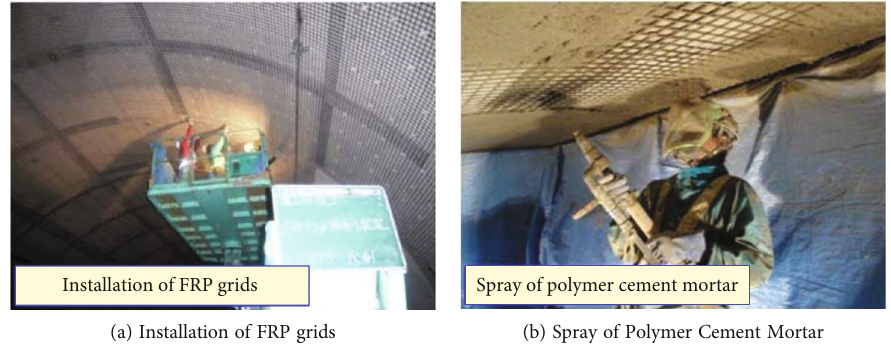
Figure 1: Reinforcement procedure with the FRP-PCM